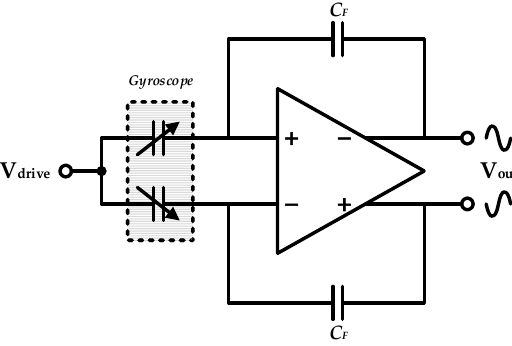
Figure 6. Di ff erential C / V converter in the proposed interface Figure 6. Differential C/V converter in the proposed interface ASIC.